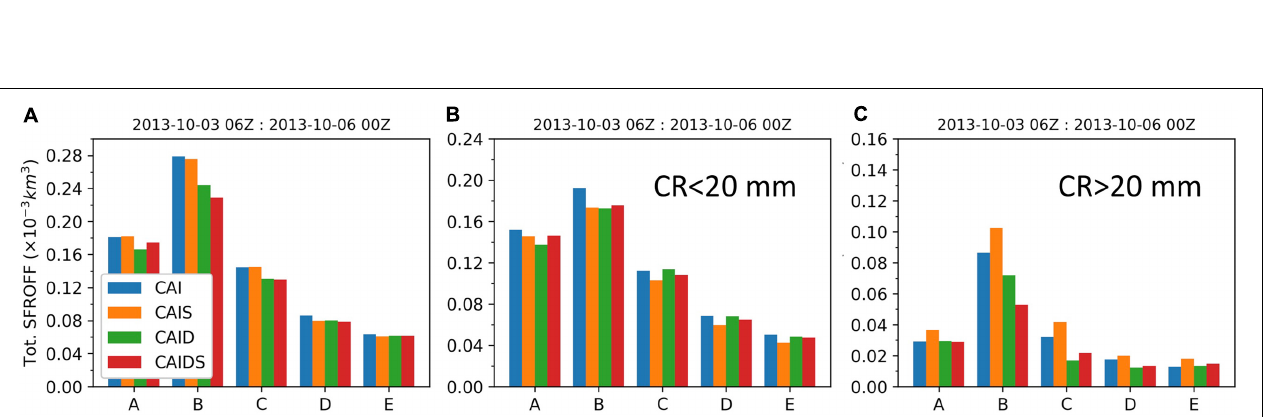
FIGURE 11 | Total surface runoff (A) from D02 (6 km) for the time of the duration of the CAI event and surface runoff stratified by grid-scale cumulative runoff depth (CR) below (B) and above (C) 20 mm for each elevation class as shown in Figure 9 . Altitudinal bands: A corresponds to the 120 km through the east of the 500 m elevation contour, B, C, D, and D correspond to 500–1,000, 1,000–1,500, and 1,500–2,000, respectively. The runoff producing area varies with elevation band (e.g., Figure 10 for CAI and